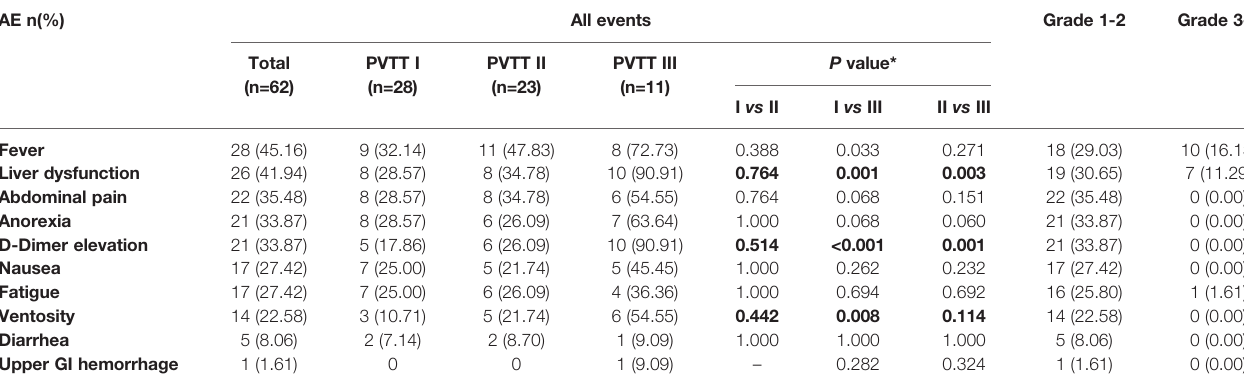
TABLE 2 | Adverse events related to the TACE treatment. Data are presented as number (%) of